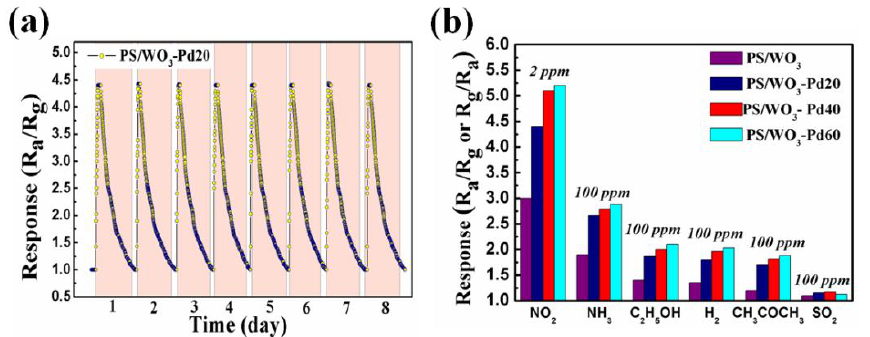
Figure 7. ( a ) The cyclic response curve of the PS/WO 3 –Pd20 sensor to 2 ppm NO 2 at RT; ( b ) the response of the PS/WO 3 sensor, PS/WO 3 –Pd20 sensor, PS/WO 3 –Pd40 sensor, and PS/WO 3 –Pd60 sensor to different gases at RT.